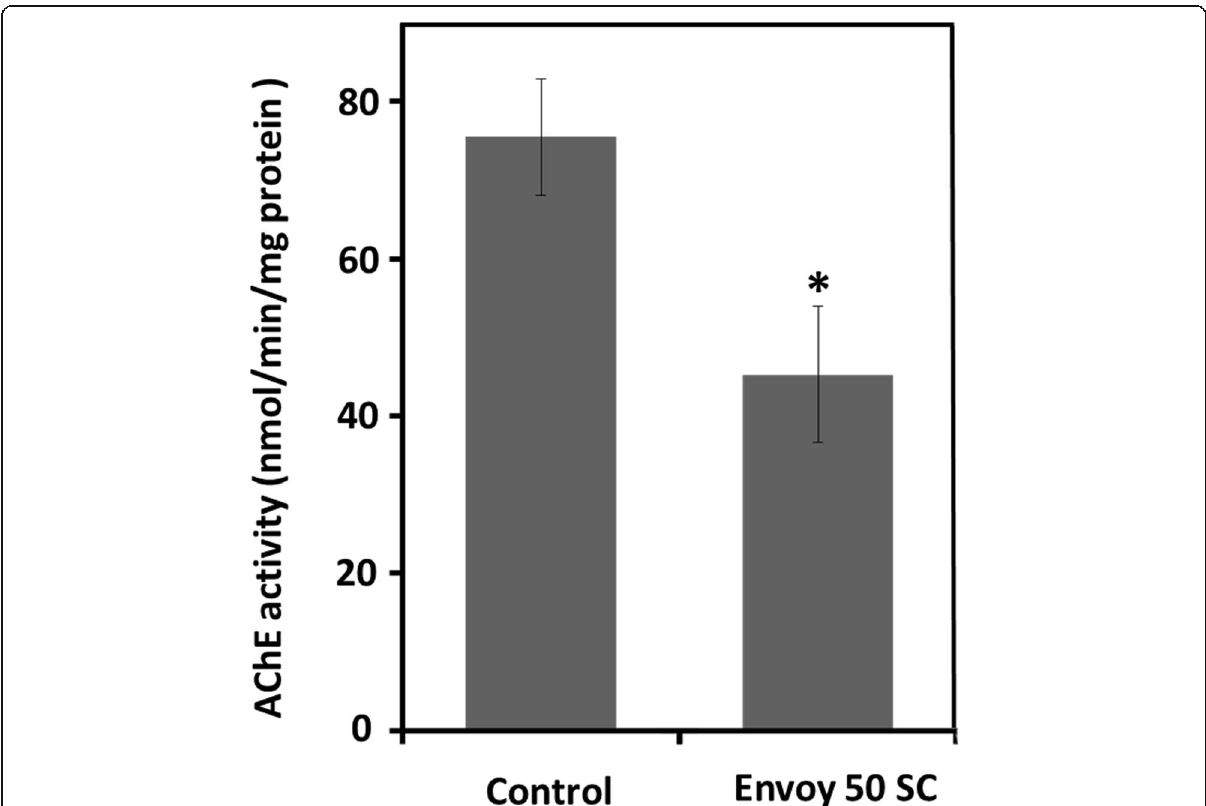
Fig. 9 AChE activity (nmol/min/mg protein) measured in brain of Heteropneustes fossilis . Fish exposed to 0.015 ppm Envoy 50 SC were compared with those of the control group. Data were presented as mean ± SD. * P <